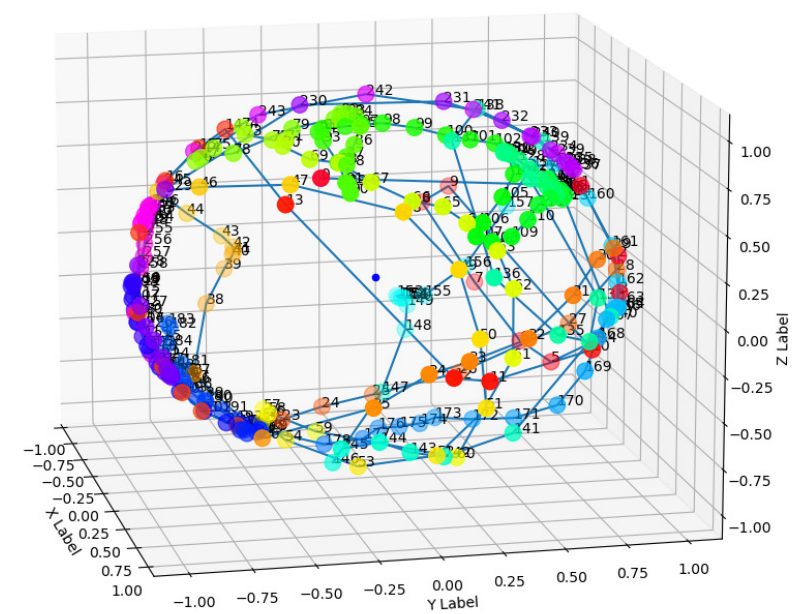
Figure 4. Direction of each sample points in a